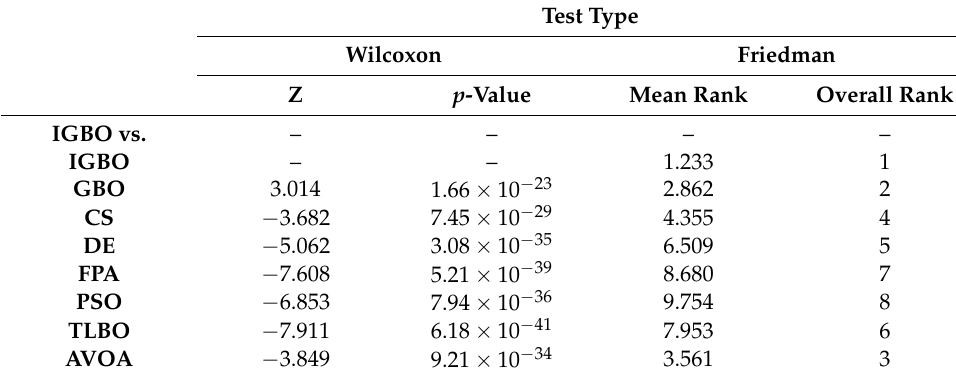
Table 10. Wilcoxon and Friedman tests for three-bar truss